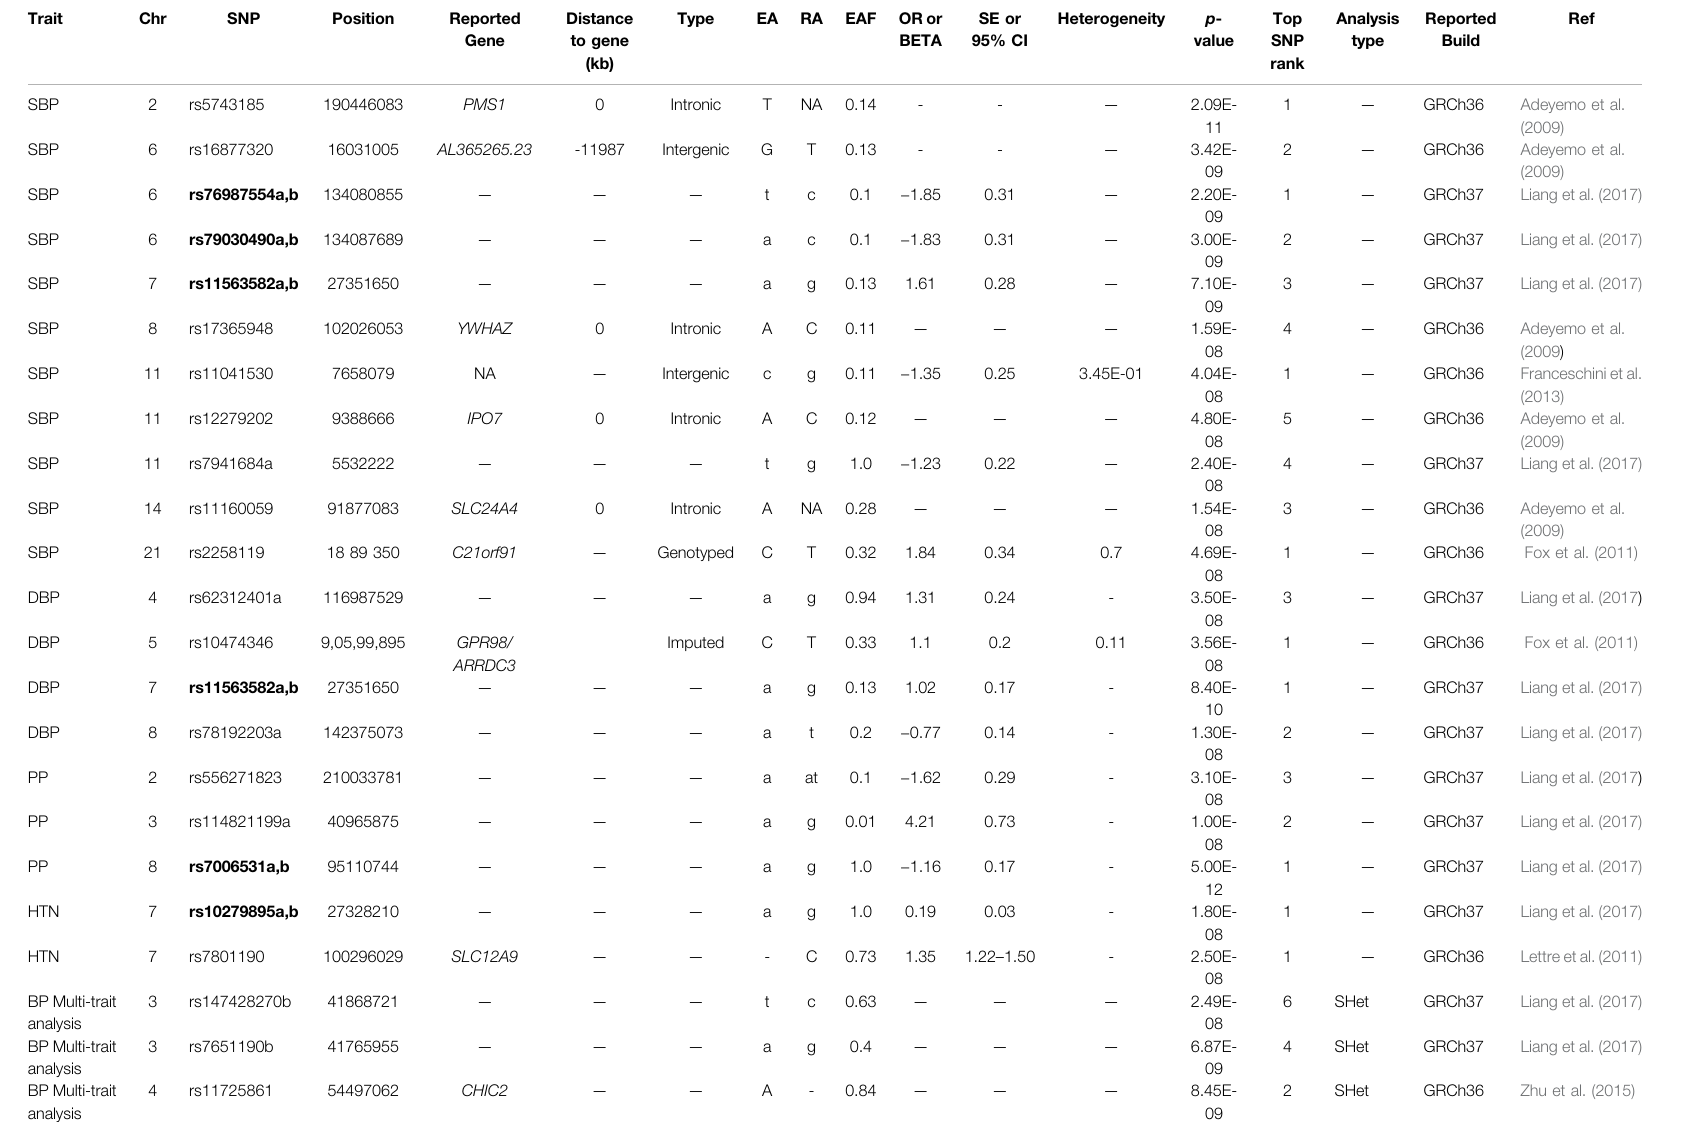
TABLE 5 | SNPs associations in the studies with only African-ancestry